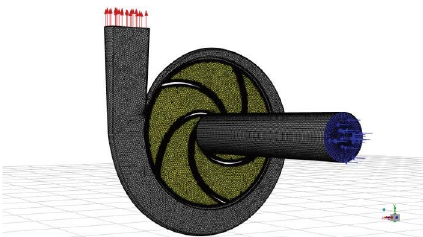
Figure 2: Boundary condition setting